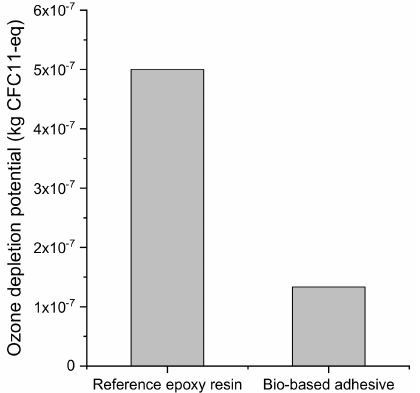
Figure 4. Comparison of ODP in terms of equivalent amount of CFC-11.